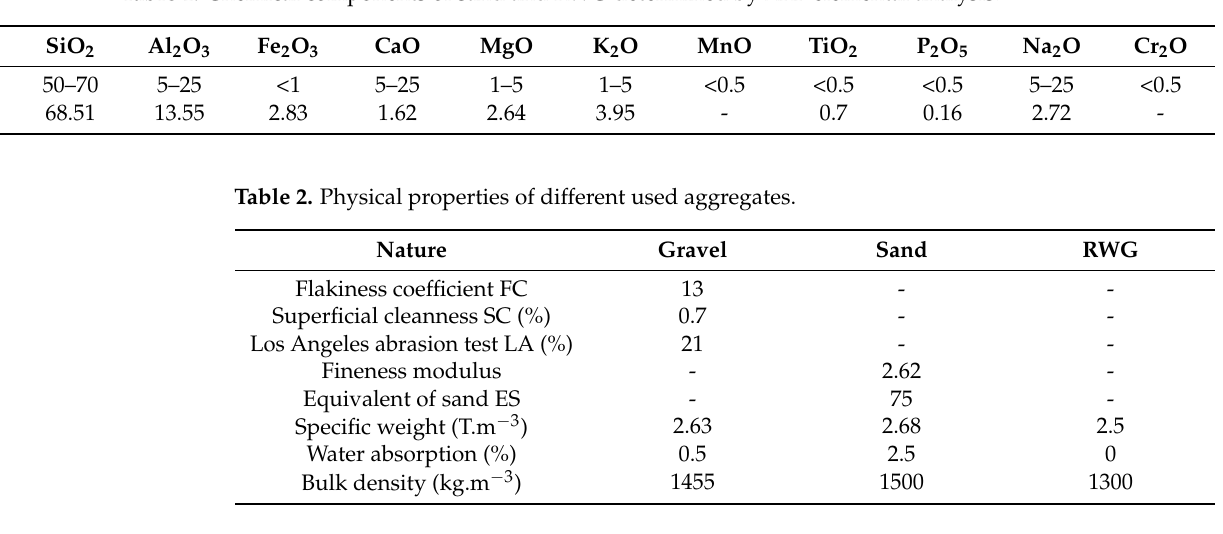
Figure 2. Granulometric analysis of sand, gravel, and recycled waste glass. Table 1. Chemical components of sand and RWG determined by XRF elemental analysis.